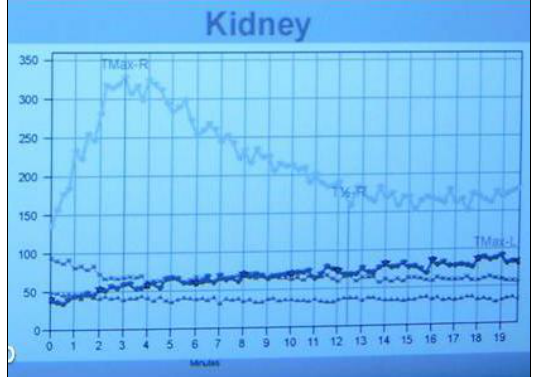
Figure 3: Tc-MAG3 showing left kidney function less than 20% of total renal function At six months, the differential function of the left kidney was reduced to less than 10%. Bladder compliance (volume/pressure) and total bladder capacity were found normal by Urodynamics. One year later, a progressive decrease of the left kidney functions was demonstrated by Left nephrectomy is planned after discussion with